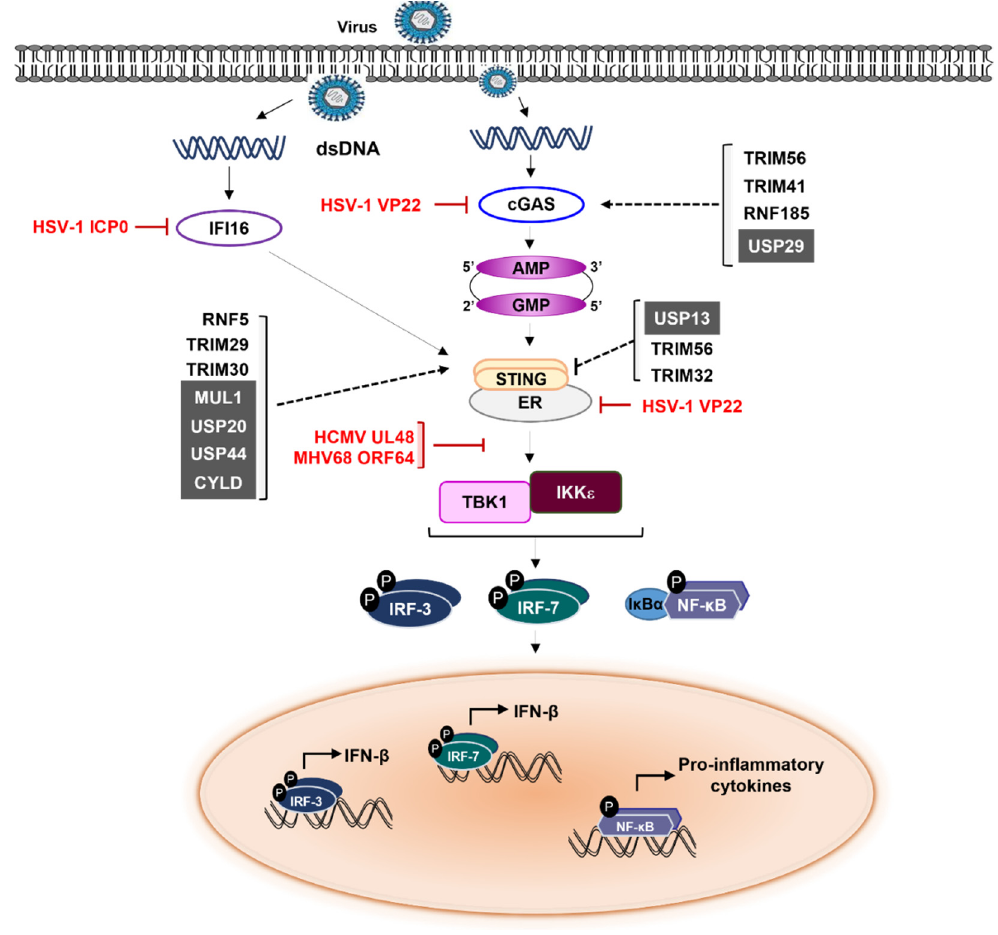
Figure 2. Herpesviruses escape tactics in cGAS ‐ STING mediated signaling cascades. cGAS recognizes DNA in the cytosol and then catalyzes the formation of cGAMP. Subsequently, cGAMP binds to and activates STING. STING translocates from the ER to the Golgi, where it interacts with and phosphorylates TBK1 and IKK. IRF3/7 and NF ‐κ B are activated by TBK1 and IKK, respectively, leading to the production of type I IFN and pro ‐ inflammatory cytokines. The words in red color indicate herpesviruses proteins. The gray boxes represent cellular DUBs. Solid lines represent cGAS ‐ STING mediated signaling pathway. The dashed lines indicate effects of cellular E3 ubiquitin ligases (or DUBs) on molecules in cGAS ‐ STING mediated signaling pathway.